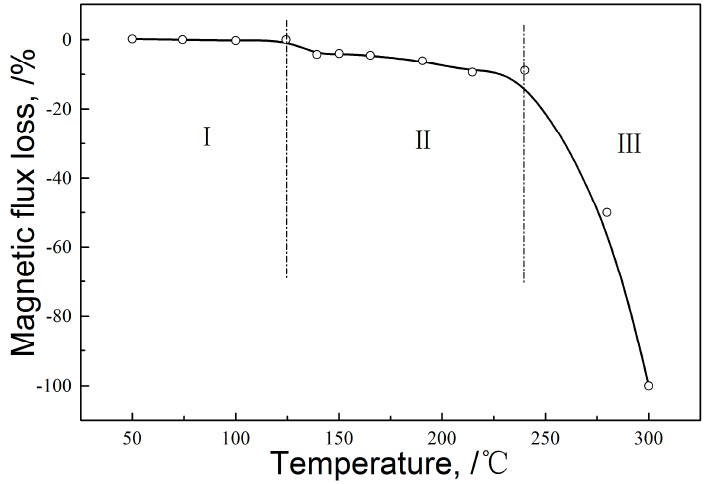
Figure 7. Thermal demagnetization curve of NdFeB permanent magnets [24,25].